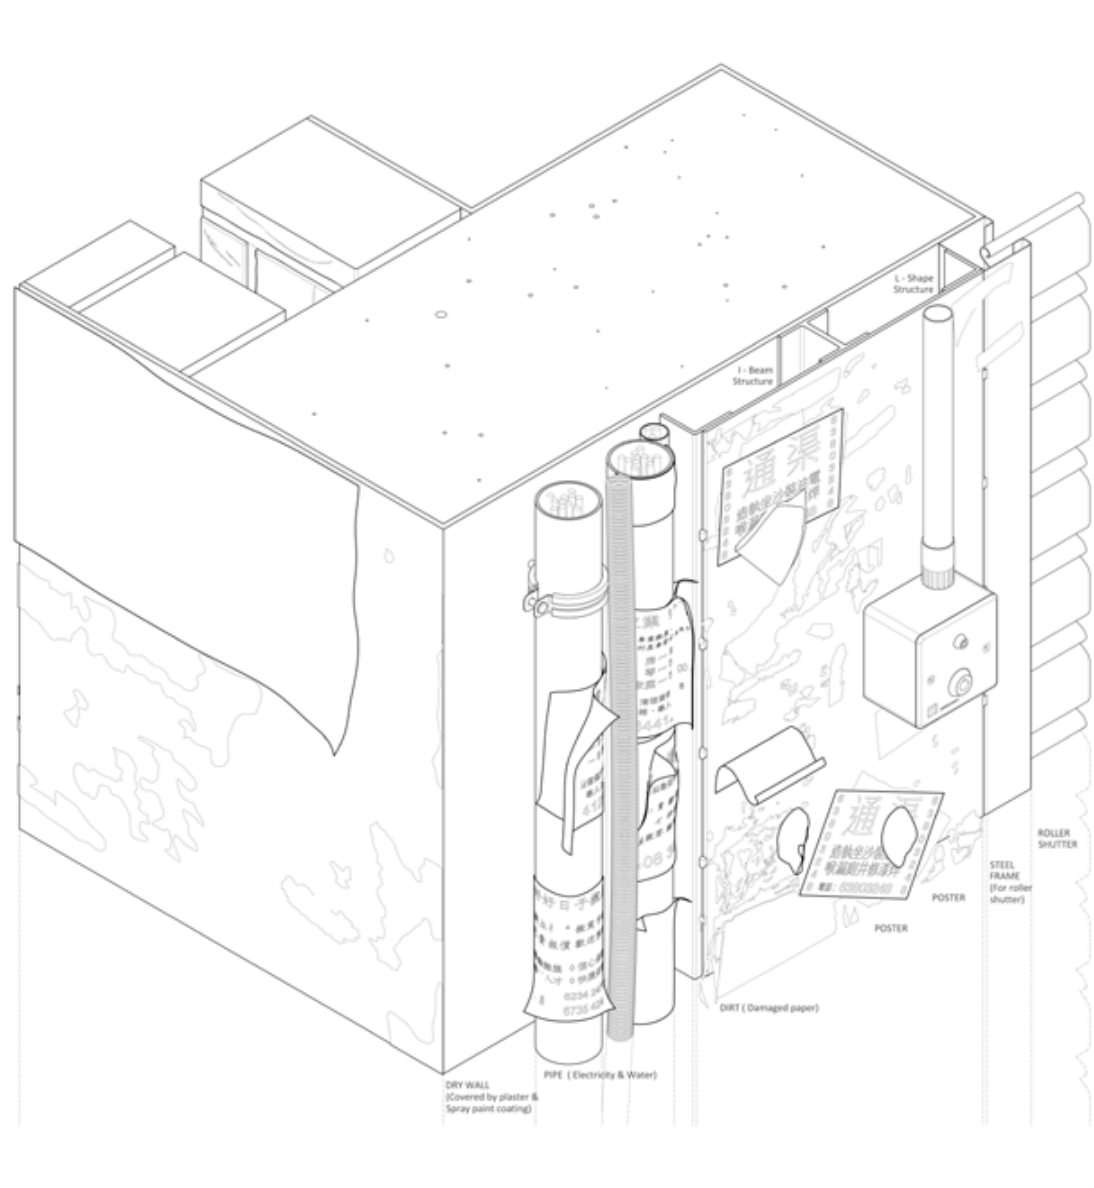
Figure 3: Vertical Studio Verisimilitude , 2018. Digital isometric drawing. Illustration by: Tam Ka Man, Wong Yuling and Leung Cheuk Sum,